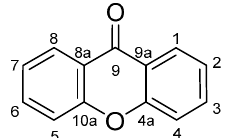
Table 1. Antimicrobial activity of natural CDXs with furan groups.